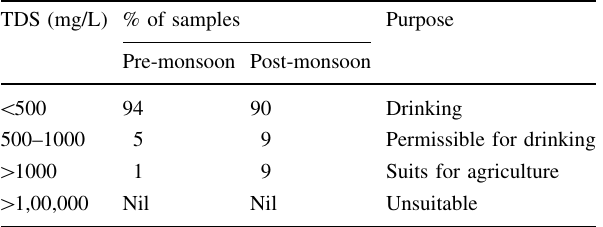
Table 3 Classification of groundwater based on TDS (Davis and DeWiest 1966) TDS (mg/L) % of samples